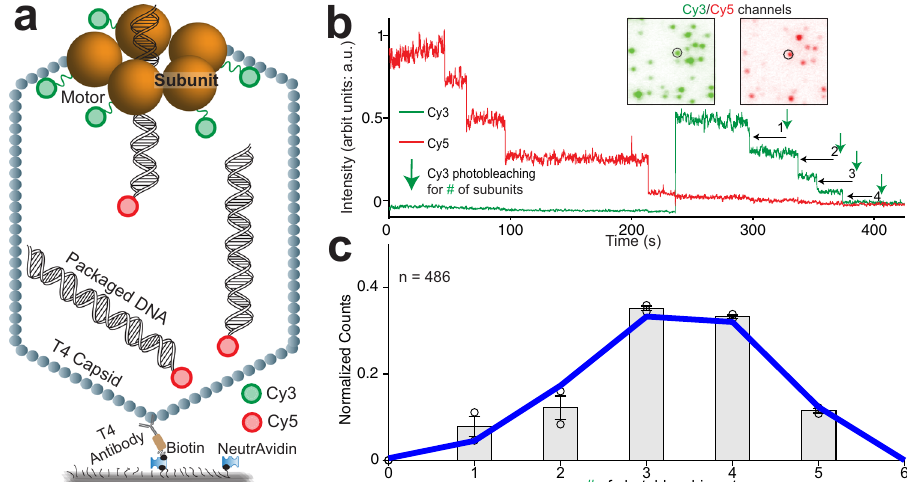
Fig. 1 Single-molecule fl uorescence assay determines a pentameric stoichiometry for the actively packaging T4 motor. a Schematic of the assay. Homomeric subunits constituting the motor are labeled with Cy3 and 45-bp dsDNA molecules are labeled with Cy5. b Representative fl uorescence time trajectories showing Cy3 and Cy5 signals, which indicate T4 motor and packaged DNA, respectively. The indicated Cy3 photobleaching steps are used to quantify the stoichiometry of the T4 motor (# of subunits forming the motor). The presence of the Cy5 signal indicates that the motor is capable of packaging DNA. The number of Cy5 photobleaching steps, indicating number of packaged DNA, can range from 1 to many. Inset: CCD images of the Cy3 and Cy5 channels from which the representative trajectories were selected. c The distribution of Cy3 photobleaching steps pooled from separate experiments and a binomial fi t (blue curve) to the distribution with n = 5 subunits (stoichiometry of the motor) and p = 0.66 (Cy3 labeling ef fi ciency). Error bars represent std. The number of trajectories used is indicated by n =